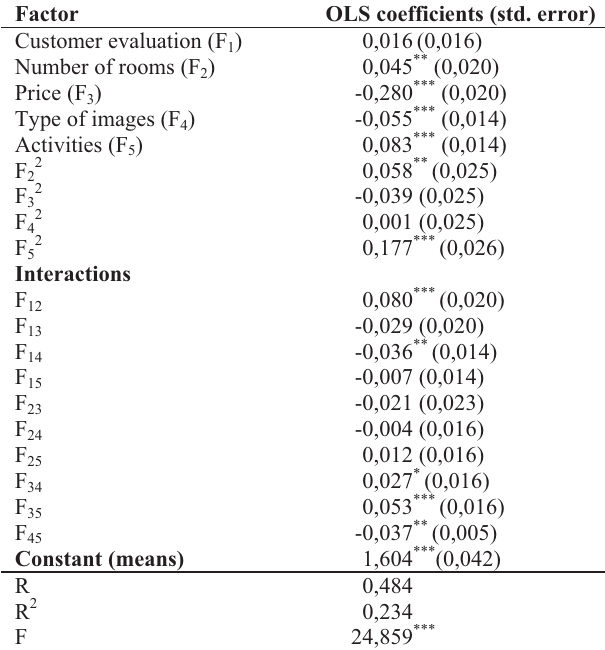
Table 1: Estimation